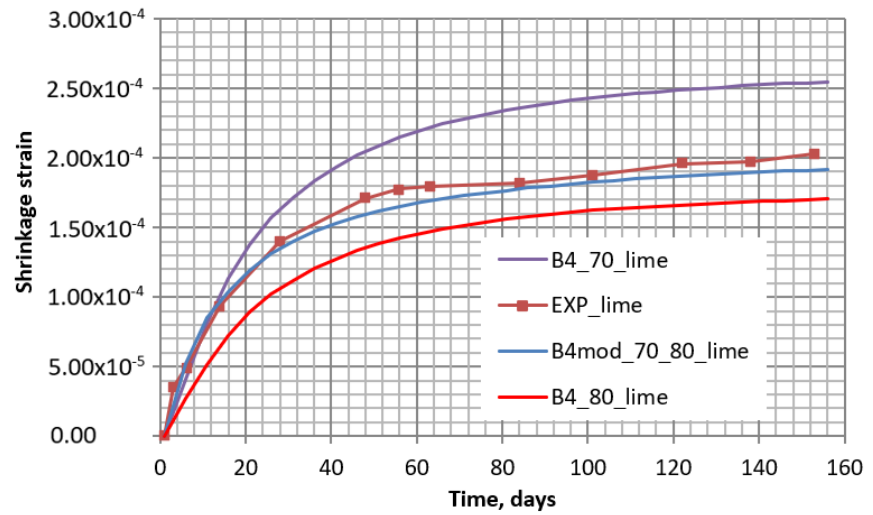
Figure 17. Shrinkage [HZ68][DZ69] of specimens with quicklime additive obtained experimen- tally (EXP_lime) and by methods B4 and B4-mod with 70% and 80% humidity (B4_70_lime, B4_80_lime, and B4-mod_70_80_lime,